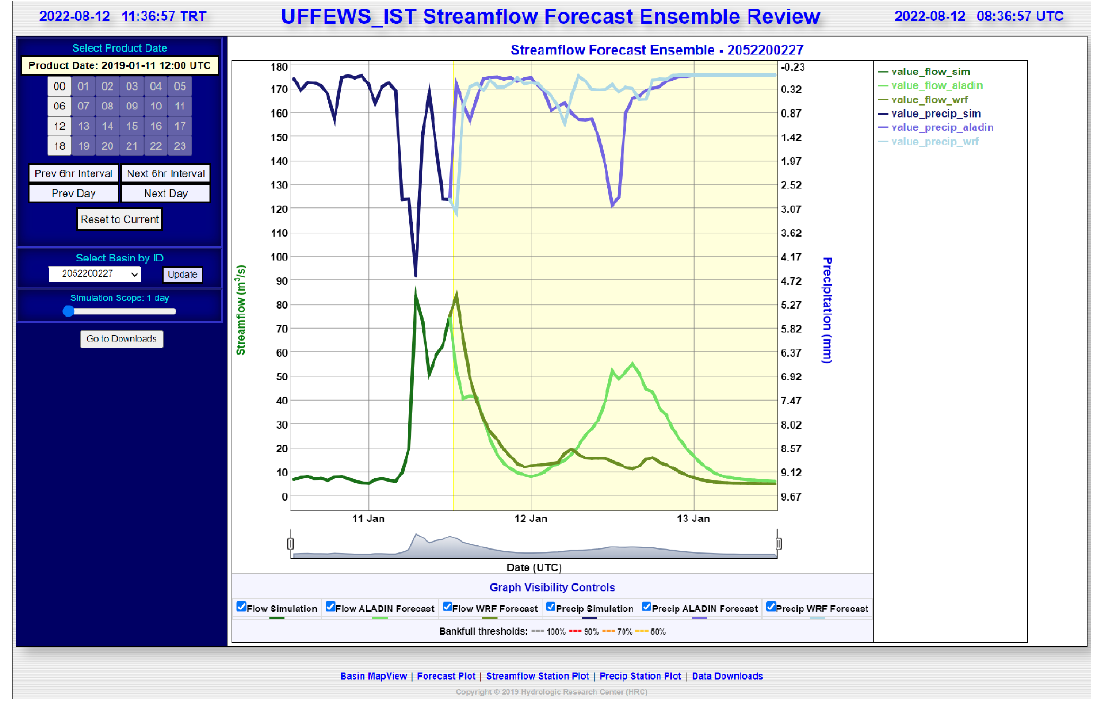
Figure 16. The Forecast Plot page of the UFFWS-Istanbul.